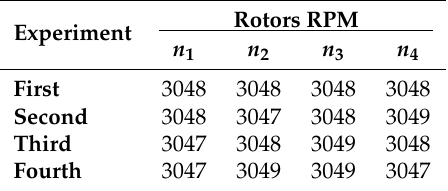
Table 1. Summary of four numerical experiments’